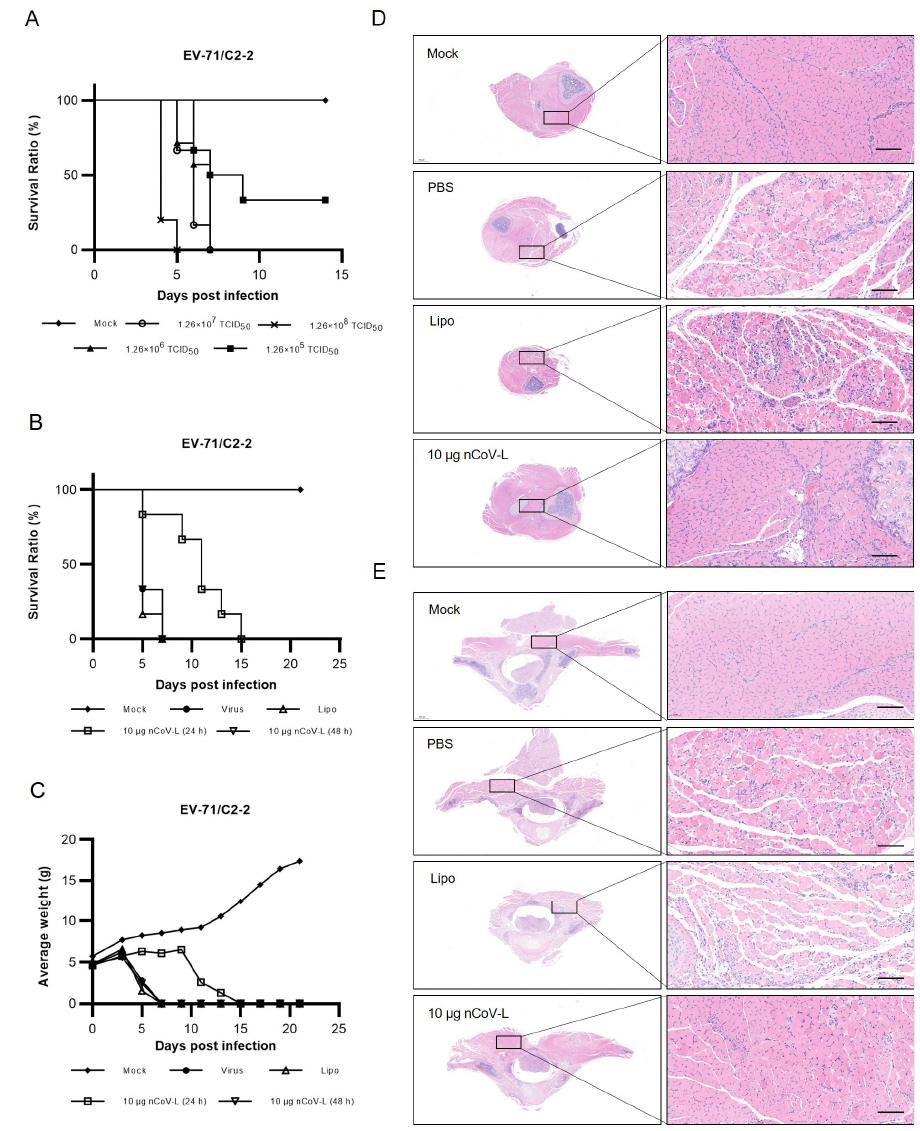
Figure A4. The therapeutic effect of nCoV-L against EV-71/C2-2 in vivo. ( A ) Seven-day-old BALB/c suckling mice (N = 6) were infected with 1.26 × 10 5 , 1.26 × 10 6 , 1.26 × 10 7 or 1.26 × 10 8 TCID 50 EV-71/C2-2 intraperitoneally. ( B , C ) Suckling mice (N = 6) were challenged intraperitoneally with 1.26 × 10 6 TCID 50 EV-71/C2-2. 10 µ g nCoV-L complexed with Lipo were intraperitoneally injected 24 h, 48 h after infection. Survival ratio and average weight were monitored every two days up to 21 DPI. Suckling mice (N = 3) were challenged intraperitoneally with 1.26 × 10 6 TCID 50 EV-71/C2-2, then injected intraperitoneally with 10 µ g nCoV-L complexed with Lipo 1 h later. ( D , E ) HE staining of hind leg and paraspinal muscle from Mock, PBS, Lipo or 10 µ g nCoV-L treated mice at 5 DPI are shown. Scale bar represents 100 µ